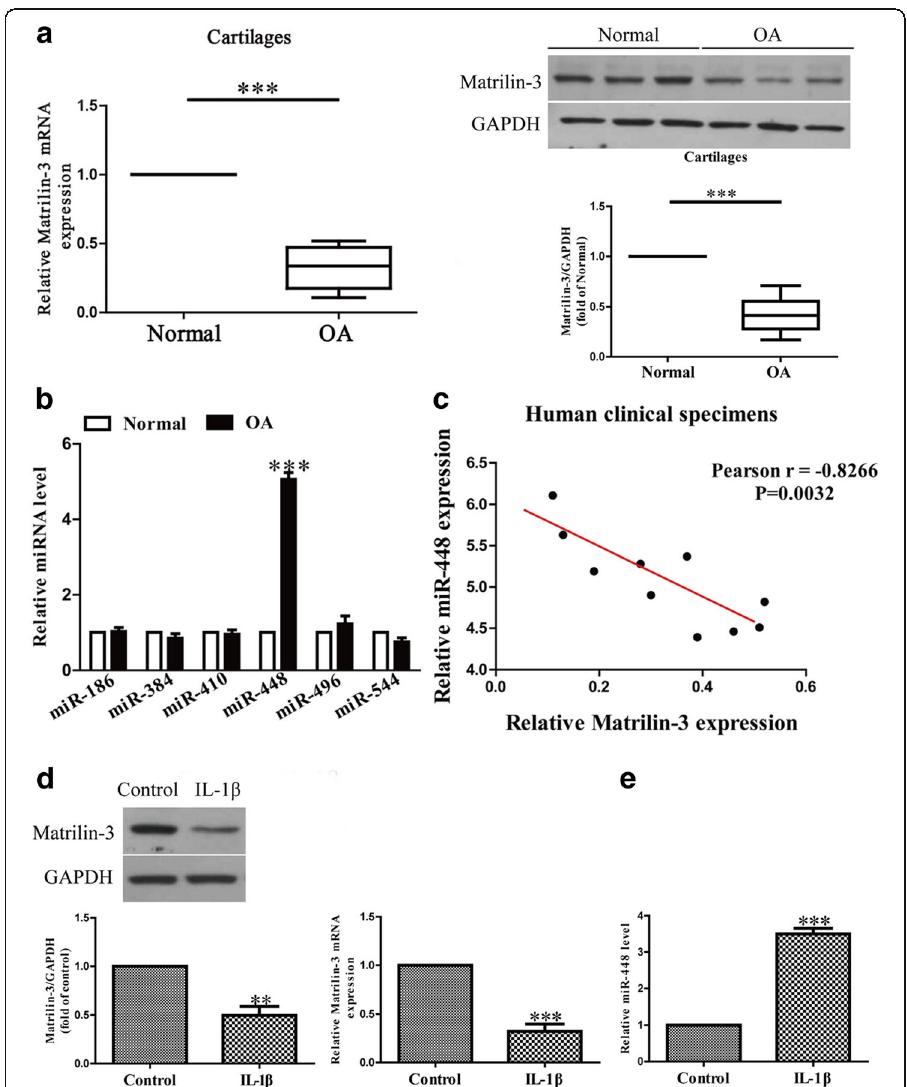
Fig. 1 The levels of matrilin-3 and miR-448 in osteoarthritis cartilage and IL-1 β -induced chondrocytes. a The mRNA and protein levels of matrilin-3 in normal and osteoarthritis cartilages were determined using quantitative real-time PCR and western blot, n =10. b The levels of miR-186, miR-384, miR-410, miR-448, miR-496 and miR-544 in osteoarthritis cartilages were determined using quantitative real-time PCR, n = 10. c Pearson ’ s correlation analysis of the relative expression levels of miR-448 and the relative matrilin-3 mRNA levels in osteoarthritis cartilage. d Chondrocytes were treated with 5 ng/ml IL-1 β for 24 h. The expression of matrilin-3 was analyzed using quantitative real-time PCR and western blot, and normalized to GAPDH, n =4. e The level of miR-448 was analyzed using quantitative real-time PCR and normalized to U6, n =4. The data shown are means ± SEM. OA: chondrocytes from patients with osteoarthritis. Normal: chondrocytes from patients without osteoarthritis. *** p <0.001 vs. normal or